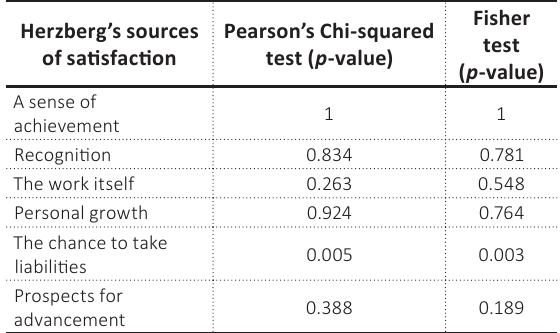
Table 4. Relationship between financial rewards and Herzberg’s sources of satisfaction